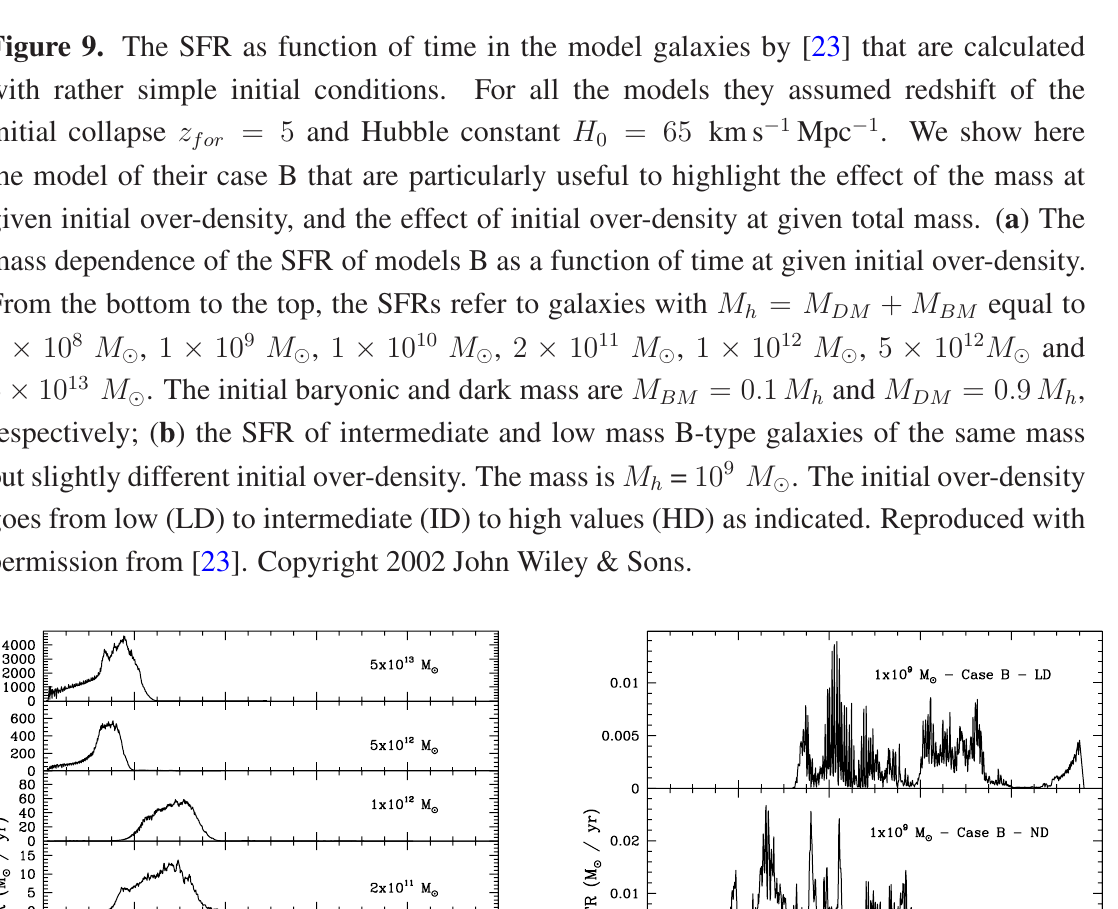
Figure 9. The SFR as function of time in the model galaxies by [23] that are calculated with rather simple initial conditions. For all the models they assumed redshift of